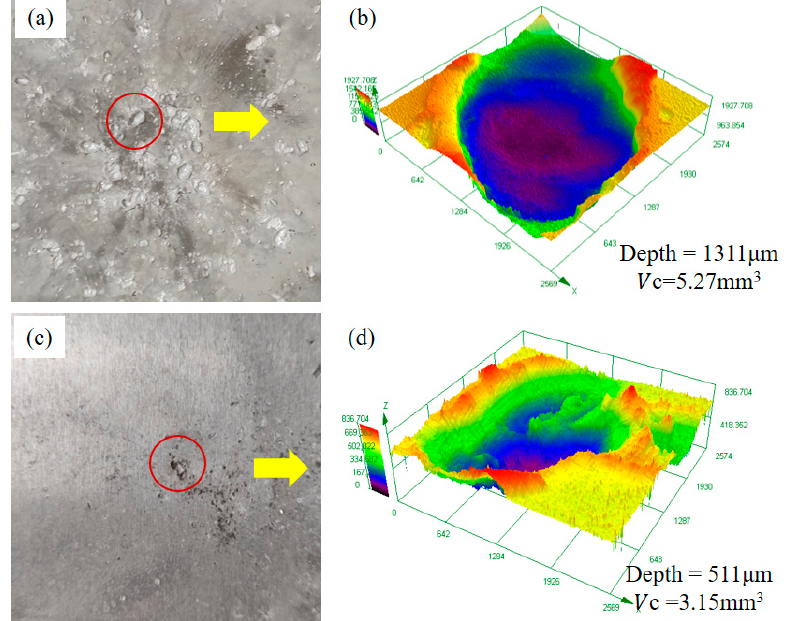
Figure 5. Microscopic morphology of the witness plate. ( a ) Impact crater in witness plate of Al plate. ( b ) Microscopic appearance of impact crater. ( c ) Impact crater in witness plate of Basalt fabric. ( d ) Microscopic appearance of impact crater.